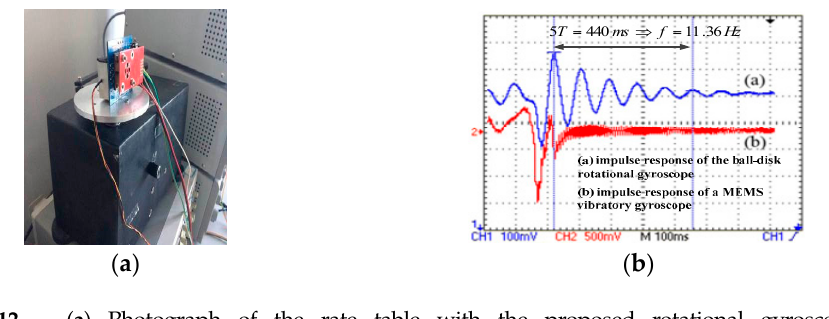
12 of 15 Sensitivity and nonlinearity of the proposed gyroscope are measured by linear fitting (with Matlab) of output voltages under evenly-distributed (with 5°/s intervals) input angular speeds from − 30°/s to 30°/s (Figure 11a). Resolution is obtained by analysis of responses to nine input angular speeds, which are exponentially-distributed from − 0.00625°/s to − 1.6°/s (noted in Figure 11a). Low frequency sensitivity, nonlinearity within input angular speed range of − 30°/s to 30°/s (limited by linearity of differential capacitance detection), and resolution is confirmed as 0.0985 V/(°/s), 0.43%, 0.1°/s, respectively. For bias stability test, no input angular speed is given, and output voltages over the time span of 0.5 h are recorded and processed. Then, bias stability is confirmed by an Allan deviation curve (lowest value of Allan deviation) to be 0.5°/h (Figure 11b). Figure 10. Spectral density of output signal. ( a ) ( b ) Figure 11. ( a ) linear fi tt ing of output voltages under input angular speed range of − 30°/s to 30°/s; ( b ) log-log plot of Allan deviation versus averaging time. To test dynamic characteristics of the proposed gyroscope and verify its functionality, the proposed rotational gyroscope and a MEMS quartz vibratory gyroscope are placed on the oscillating platform as shown in Figure 12a. An impulse angular speed is given by the oscillating platform and